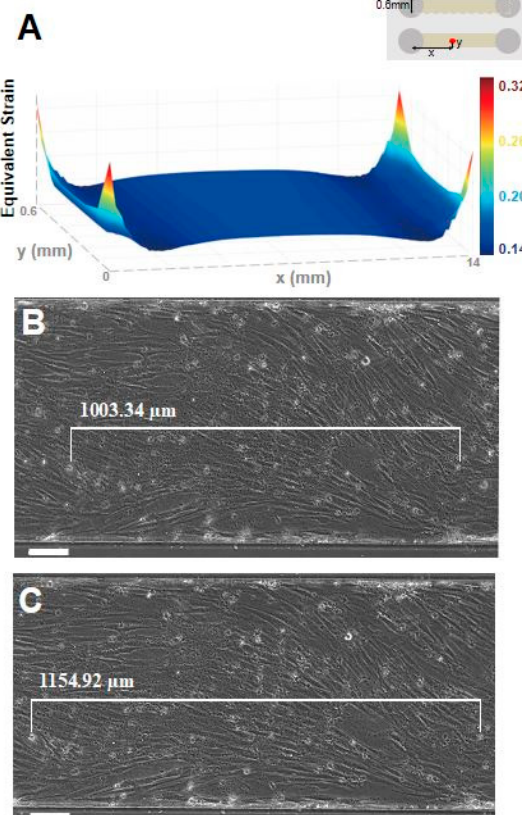
Figure 2. Stretcher simulation and validation on single channel device. ( a ) Simulation confirms about 15% equivalent elastic strain predominantly exists along the bottom surface of single channel device when 18% uniaxial stretch was given by the stretcher. The upper right inset shows the orientation of simulated microfluidic chip. Microscopic images of the device with cells ( b ) before and ( c ) after applying 18% elongation were used to measure the strain value applied to the cells. The distance between specific cells was measured before (1003.34 µm) and after (1154.92 µm) applying stretch, giving a total of 15.11% strain on the cell cultured device. (scale bar: 100 µm).